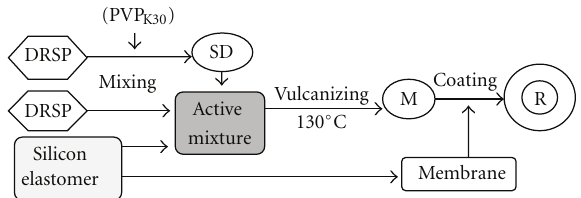
F2:FlowchartofpreparingIVRprocess.DRSP:drospirenone;